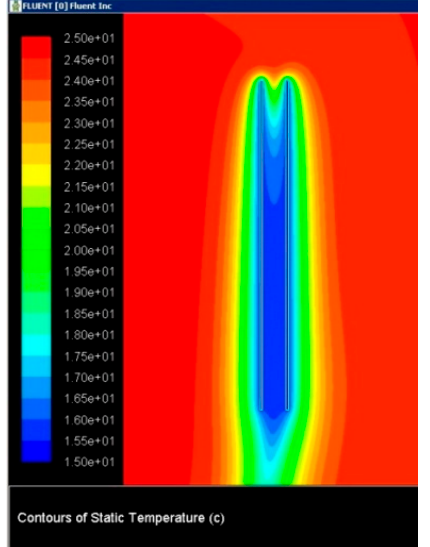
Table 2. Calculated isothermal cooling performance for plates.